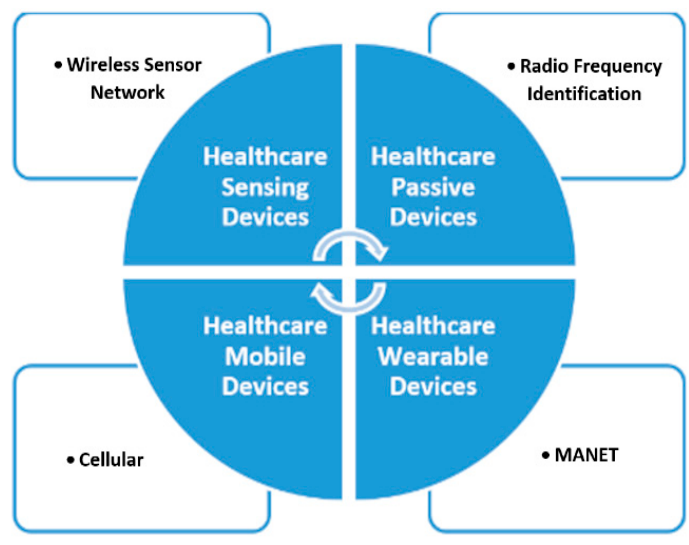
Figure 4. Simple overall view of the proposed healthcare system.